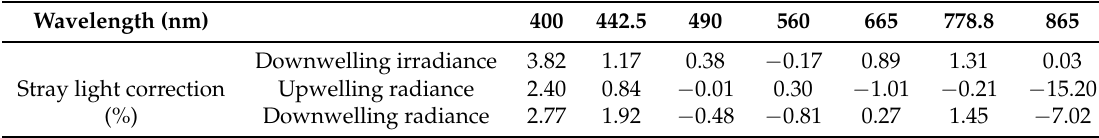
Table 2. Stray light correction values applied to the three radiometers in the ideal case and used as the standard deviation of a Gaussian distribution in the non-ideal